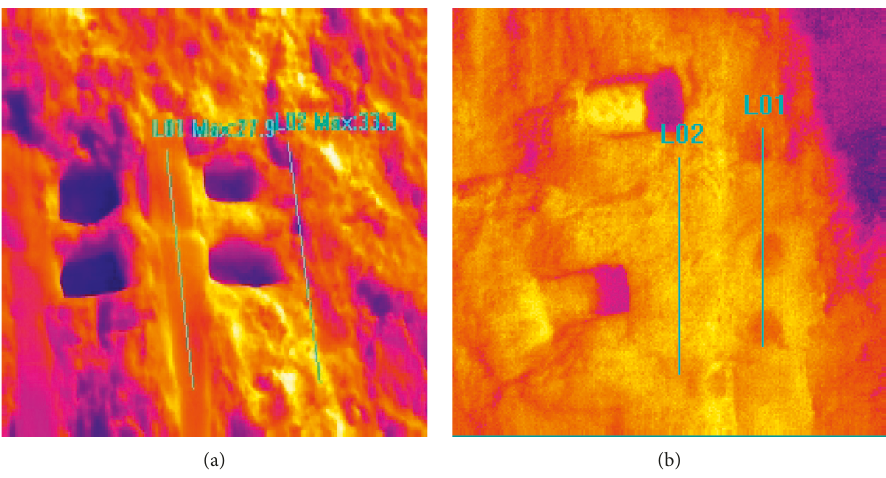
Figure 8: Infrared thermograms: (a) traditional grouting and (b) optimized grouting.